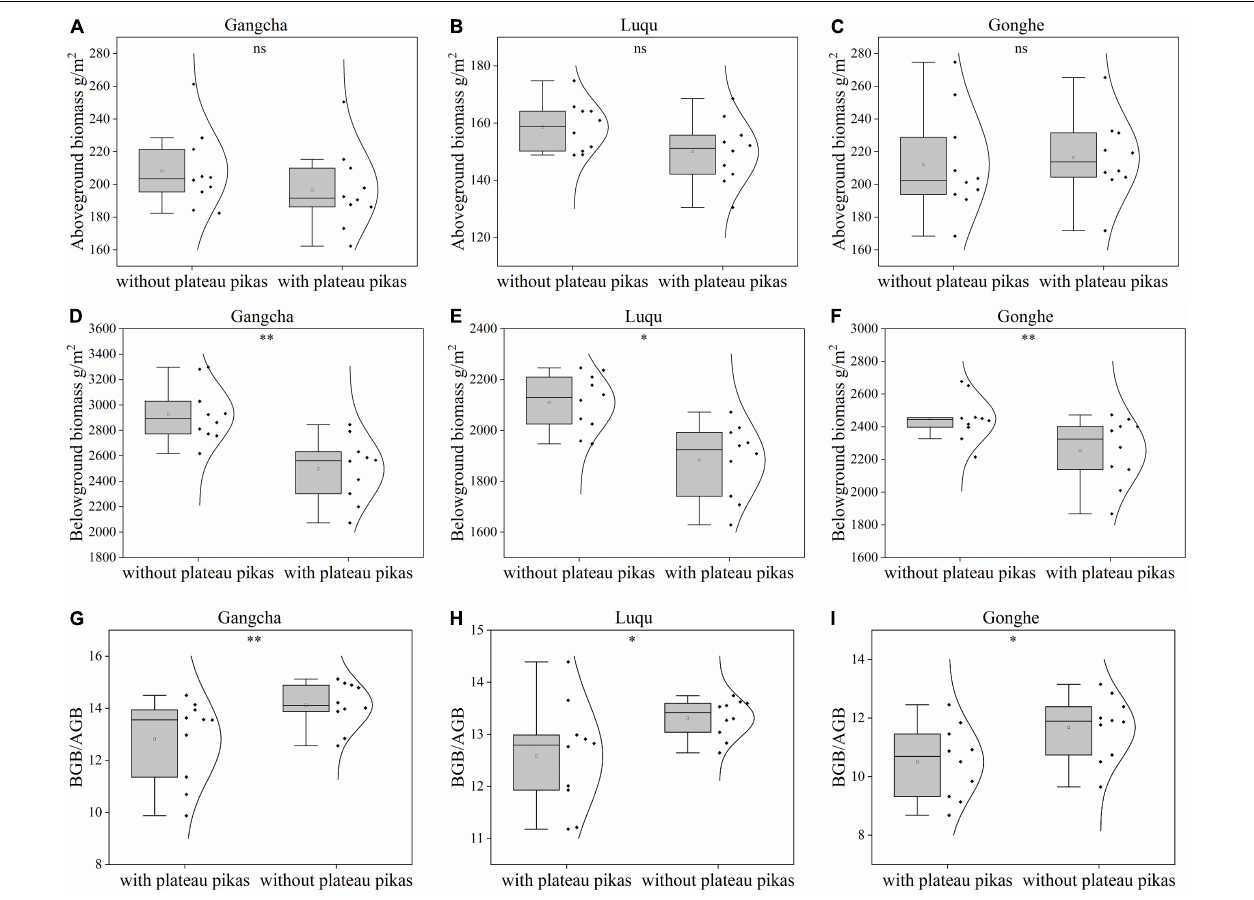
FIGURE 3 | AGB, BGB, and ratio of BGB and AGB in the presence and absence of disturbance by plateau pikas at Gangcha ( A : AGB, D : BGB, G : BGB/AGB), Gonghe ( B : AGB, E : BGB, H : BGB/AGB), and Luqu ( C : AGB, F : BGB, I : BGB/AGB). ∗ Significant differences at p < 0.05, ∗∗ p < 0.01, ∗∗∗ p < 0.001, ns p >